Question: Author a descriptive caption for the visualization shown.
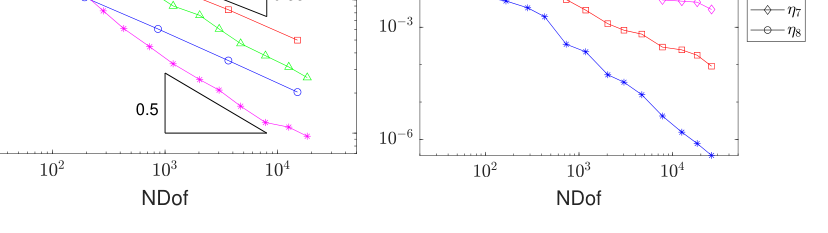
Answer: Left panel displays NDof vs error in energy norm and estimator in both uniform and adaptive reﬁnements, and right panel displays estimator components in adaptive reﬁnement for nonconforming VEM.